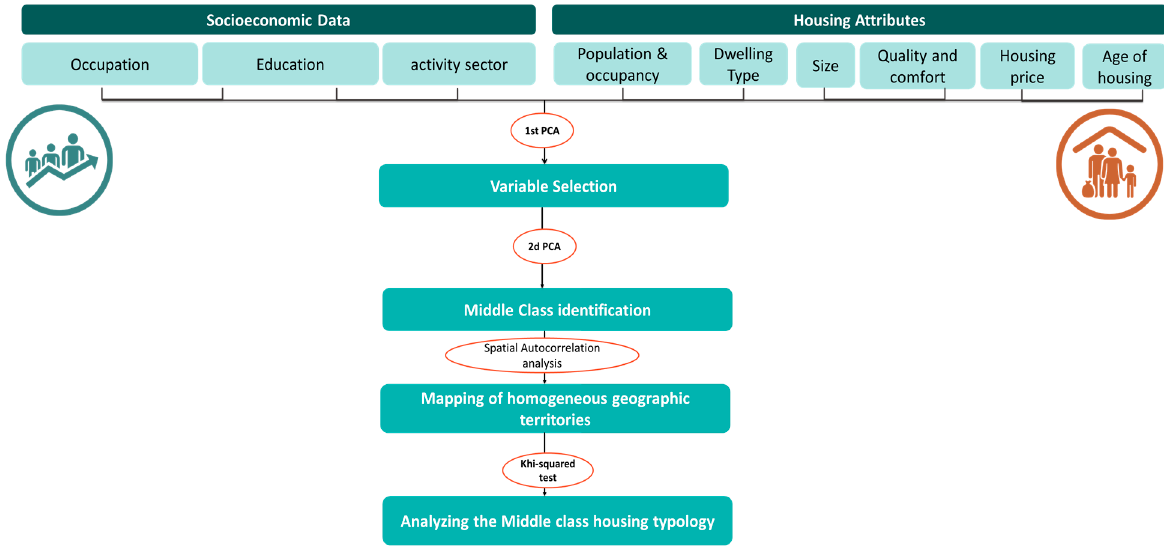
Figure 3. Flow chart of the used methodology.